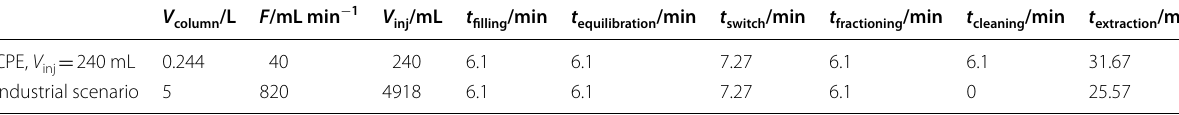
Table 2 Process step times in CPE columns with a volume of 244 mL and 5